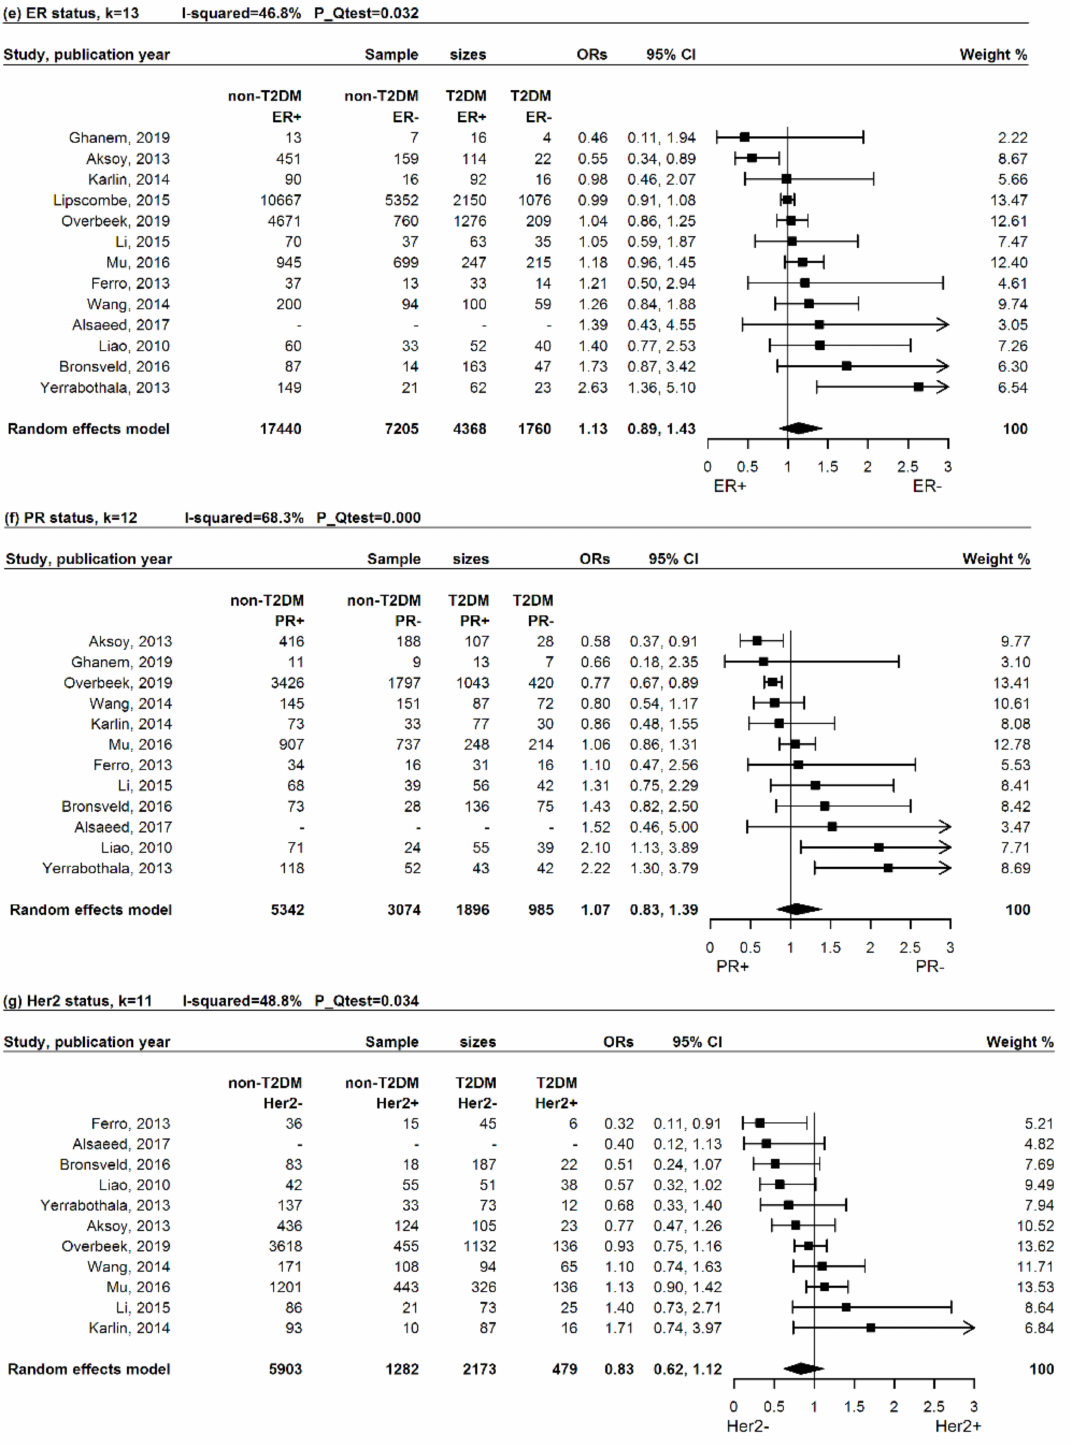
Figure 2. Forest plots of the associations between T2DM and tumor characteristics at diagnosis of breast cancer. Forest plots were created for the associations between T2DM and ( a ) tumor stage, ( b ) tumor size, ( c ) lymph node status, ( d ) tumor grade, ( e ) ER status, ( f ) PR status, and ( g ) Her2 status. As for the article “Alsaeed, 2017”, sample sizes of patients with and without diabetes by ER/PR/Her2 status were unavailable; therefore, the total sample sizes did not include the population in this study. T2DM, type 2 diabetes mellitus; LN, lymph node; ER, estrogen receptor; PR, progesterone receptor; Her2, human epidermal growth factor receptor-2; ORs, odds ratio; CI, confidence interval; P_Qtest, p -value from